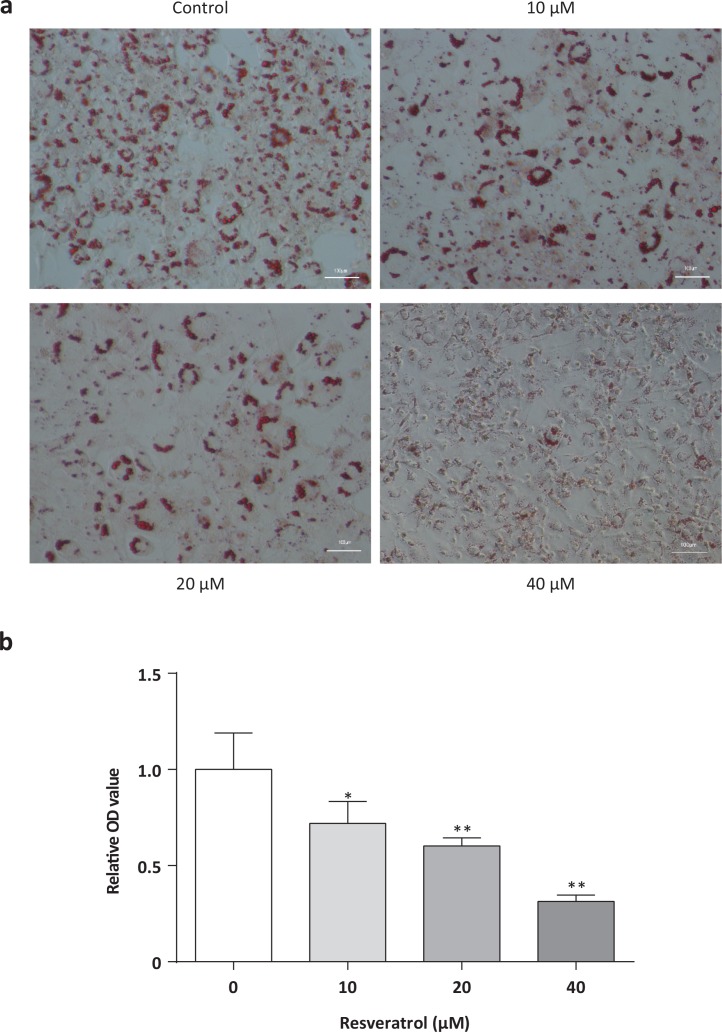
Effects of resveratrol on lipid accumulation in 3T3-L1 adipocytes. Oil Red O staining of mature 3T3-L1 adipocytes captured at 200× magnifications (a) and relative optical density (OD) value determined at OD540 (b). Oil O Red images were from 3T3-L1 adipocytes treated with Res for 8 days. All data are presented as the mean ± standard deviation (SD), and differences between groups were determined by one-way analysis of variance (ANOVA) using the Statistical Package of Social Science (SPSS, version 20.0; SPSS Inc.) program, followed by Tukey’s post hoc tests. Statistical significance between control and Res-treated groups is shown as *P < 0.05 or **P < 0.01. The amount of DMSO was 0.08% in control.